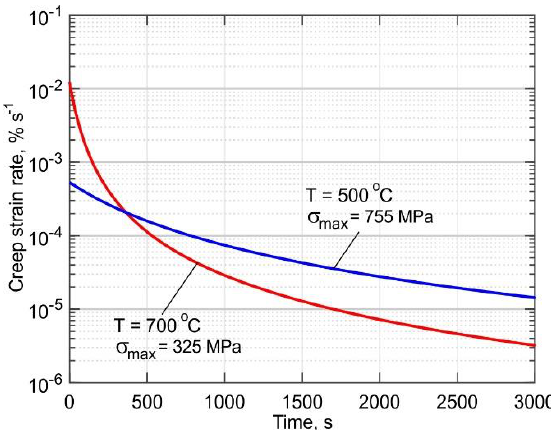
Figure 16. Creep rate curves of the DLD-processed Ti-6Al-4V for 500 °C and 700 °C.